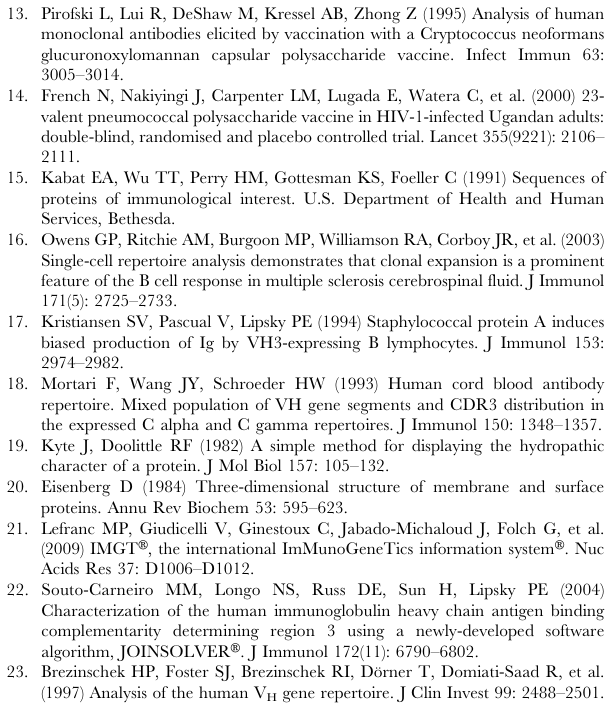
Table S1 Nucleotide mutations and adjacent nucleotide patterns in IgG V H 3 mRNA sequences. The ratios of purine (R; A or G) and pyrimidine (Y; C or T) nucleotides adjacent to mutations are listed in table S1 for both the 2 1 position (nucleotide preceding the mutation) and the + 1 position (nucleotide succeeding the